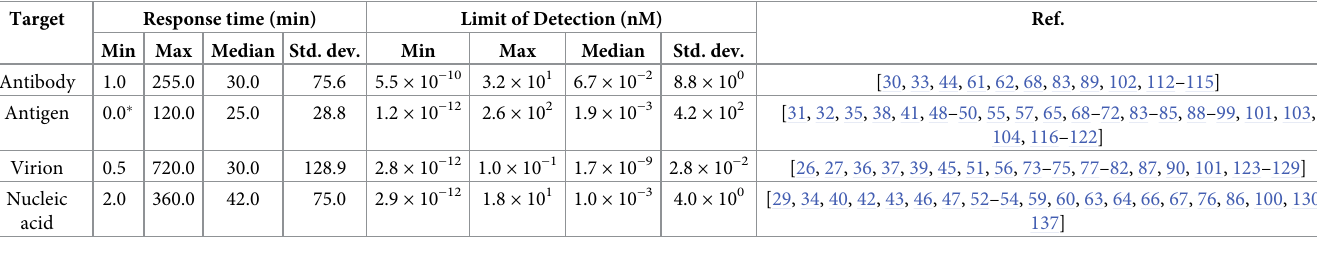
Std. dev.: standard deviation. ( � indicates 10 milliseconds.)